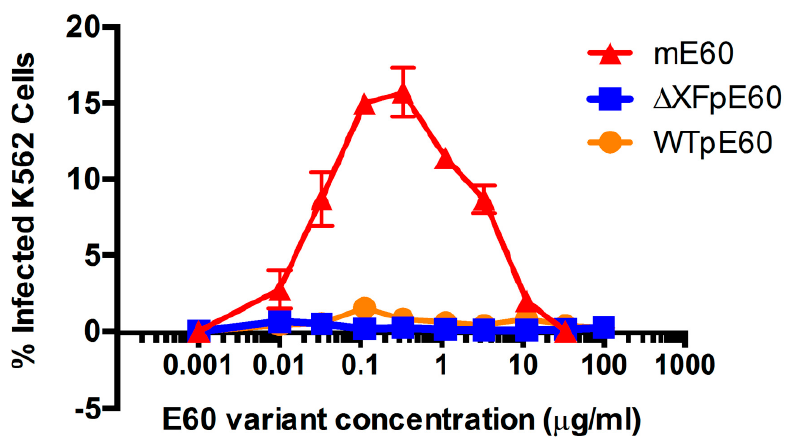
Figure 6. Antibody-dependent enhancement of pE60 variants. Serial dilutions of E60 variants were mixed with DENV-2 and added to Fc γ R-expressing K562 cells. Forty-eight hours later, cells were fixed, permeabilized and stained with anti-DENV E antibody 4G2 and analyzed by flow cytometry for DENV infection of cells. (From [104] with permission from JGV).